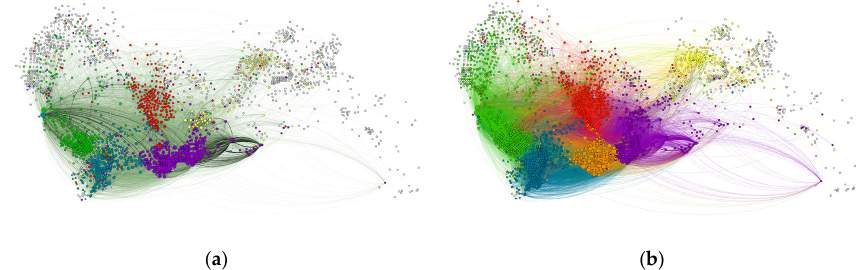
Figure 8. The directed network of daily taxi flow: ( a ) Network on weekdays; ( b ) network on weekends.